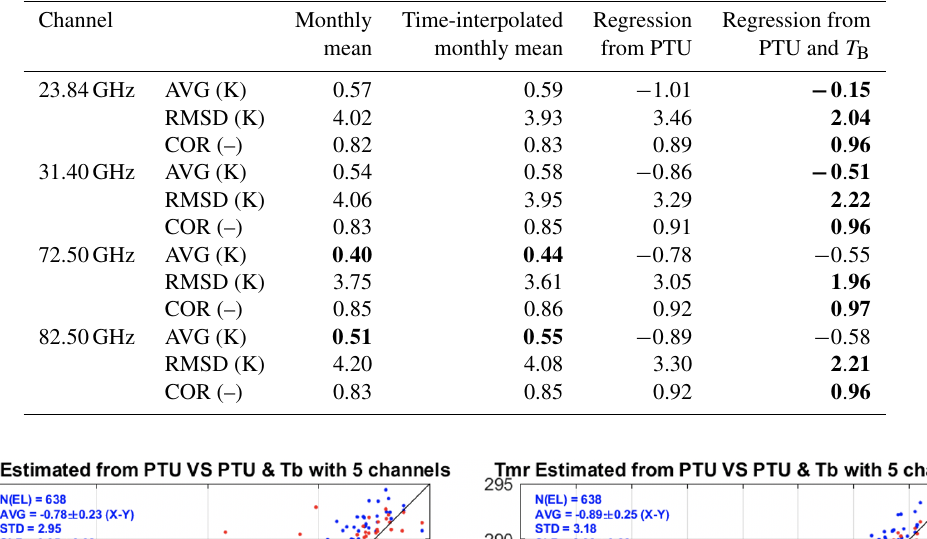
Table 1. Average difference (AVG), root mean square difference (RMSD), and correlation coefficient (COR) with respect to reference T MR (computed from radiosondes) for T MR estimated from four methods: monthly mean, time-interpolated monthly mean, regression from PTU, and regression from PTU and T B . The best scores are in bold.